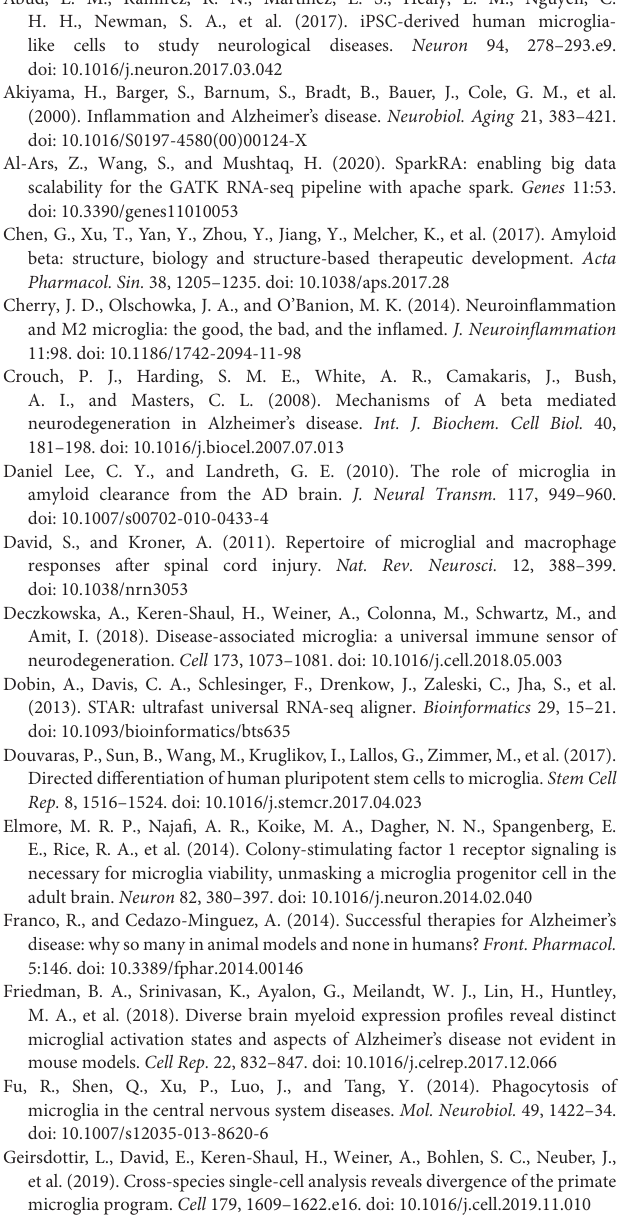
Supplementary Table 1 | Sample information for RNA-seq profiling. Supplementary Table 2 | Microglia signature genes in this study. Supplementary Table 3 | Datasets for MDS analysis in this study. Supplementary Table 4 | DEGs between iMG cells and monocytes. Supplementary Table 5 | DEGs between Ref_hMG and